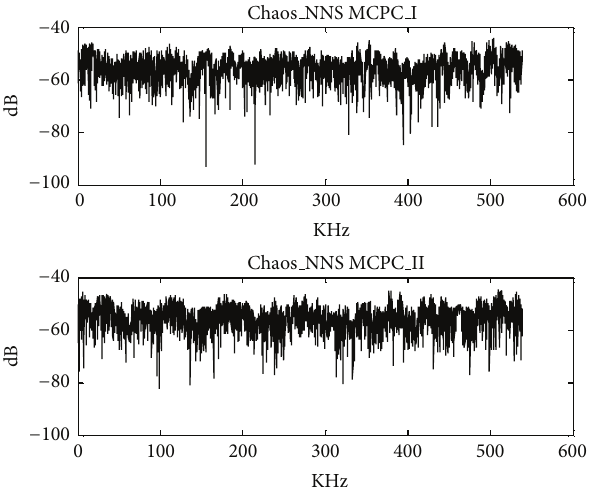
Figure 11: Power spectra of Chaos NNS MCPC I and Chaos NNS MCPC